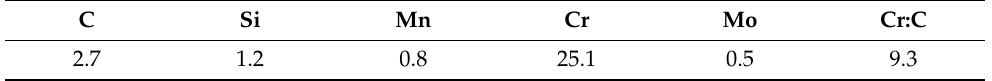
Table 1. Basic chemistry of the experimental high-chromium cast iron